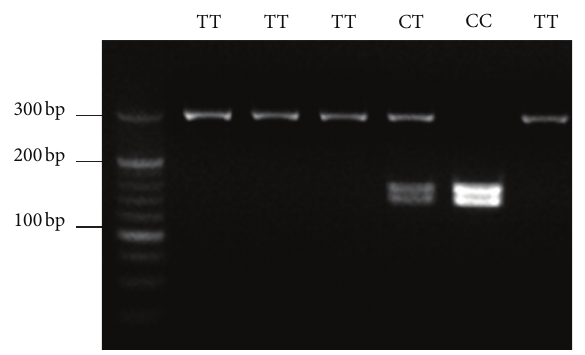
Figure 1: Detection of the − 159C/T polymorphism of CD14 gene by using PCR-RFLP. Digestion of the PCR products yielded bands of 295 bp in TT homozygotes, 140 and 155bp in CC homozygotes, and all 3 bands (140, 155, and 295bp) in